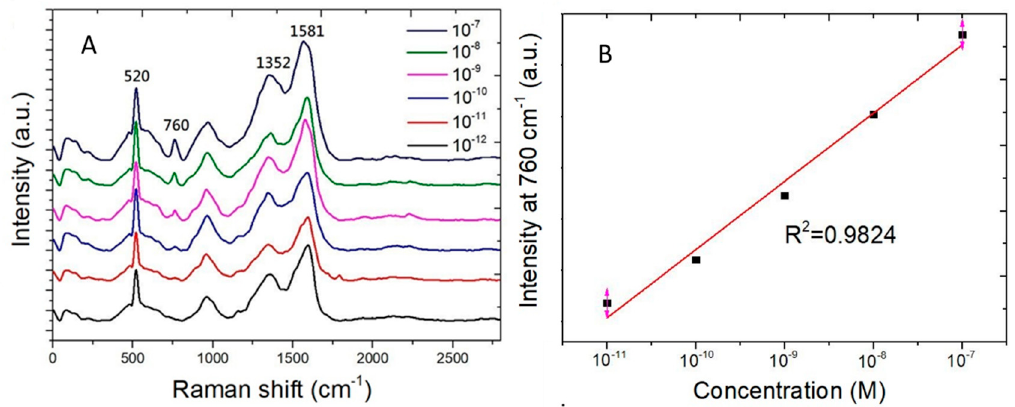
Figure 7. Raman scattering peak at 760 cm − 1 measured from adenine water solution of the concentration ranging from 10 − 7 M to 10 − 12 M. ( A ) Raman spectra. ( B ) The Raman scattering signal strength at 760 cm − 1 as a function of adenine concentration in water. The curve fitting shows a coefficient of determination (R 2 ) being 0.9824.